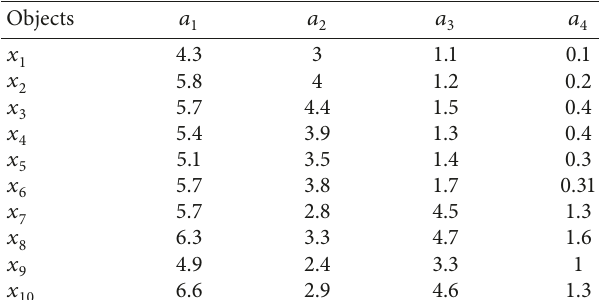
Table 5: Original dataset of Table 6. Objects